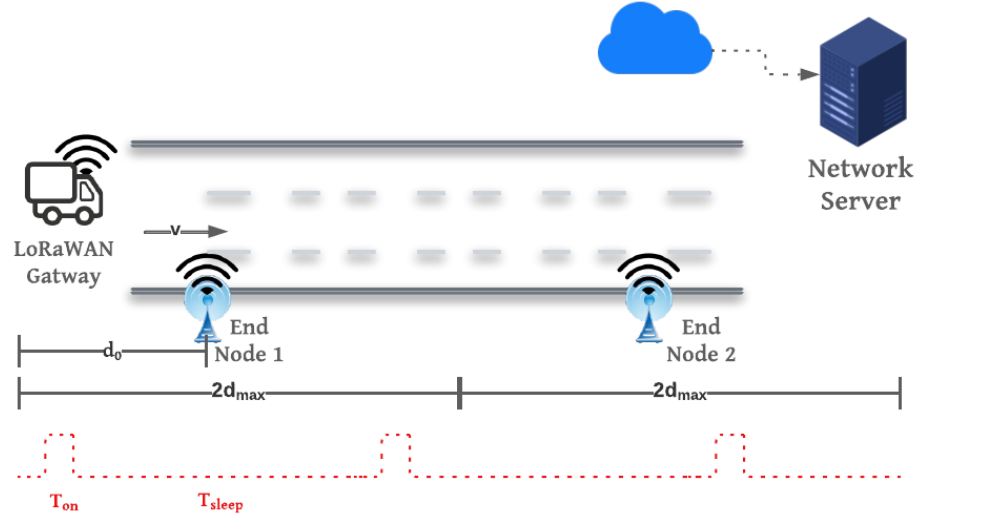
Figure 3. Proposed system